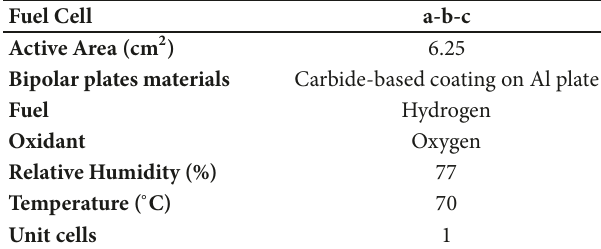
Table 3: Construction and operational parameters of fuel cells presented in Figure 5.